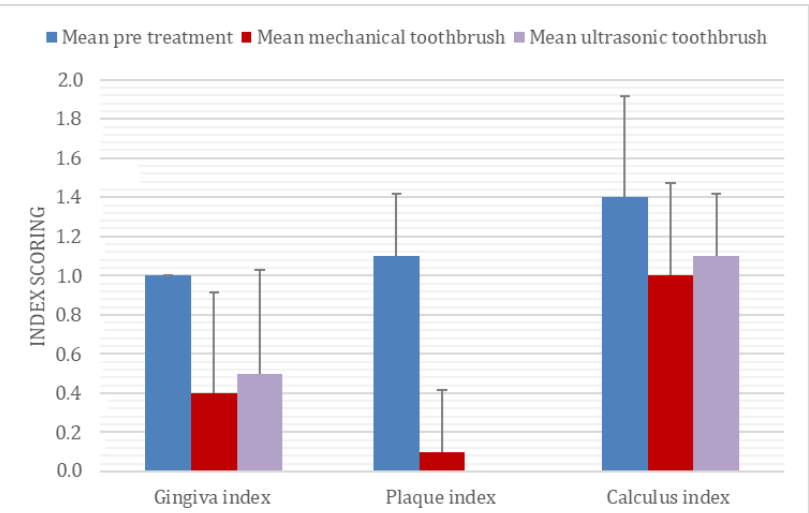
Figure 1. Mean ± SD before and after 35 days of daily dental cleaning with manual or ultrasonic toothbrush in 10 beagle dogs.